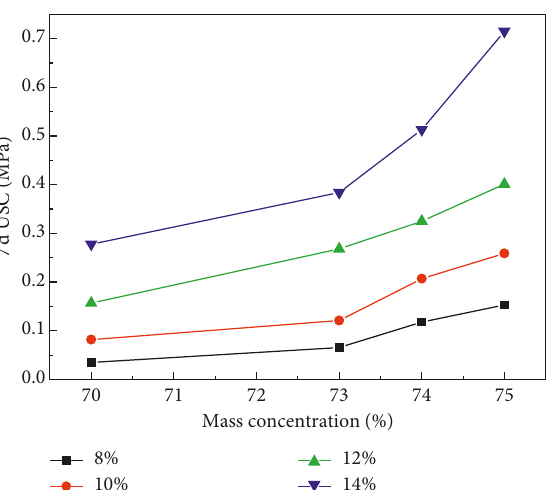
Figure 7: UCS of the mass concentration at 7days.